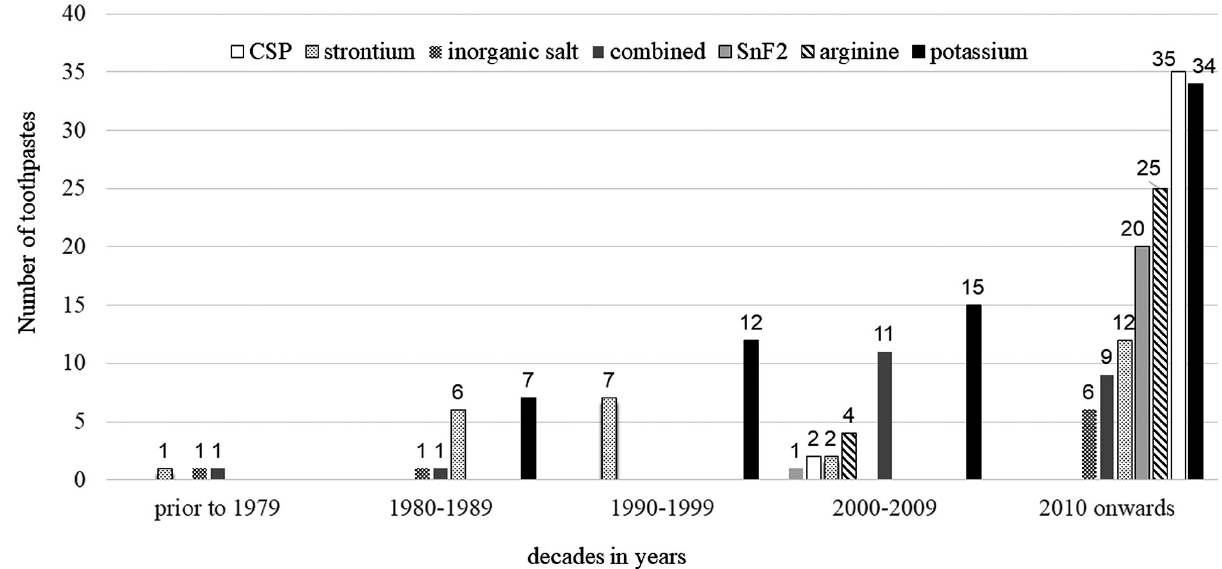
Figure 2- Distribution of the most common active ingredients studied over the decades. CSP: calcium sodium phosphosilicate; SnF2: stannous fluoride; Combined: potassium compounds + copolymer, potassium compounds + herbal, potassium compounds + hydroxyapatite, potassium compounds + inorganic salt, potassium compounds + SnF2, potassium compounds + strontium compounds, and inorganic salt +